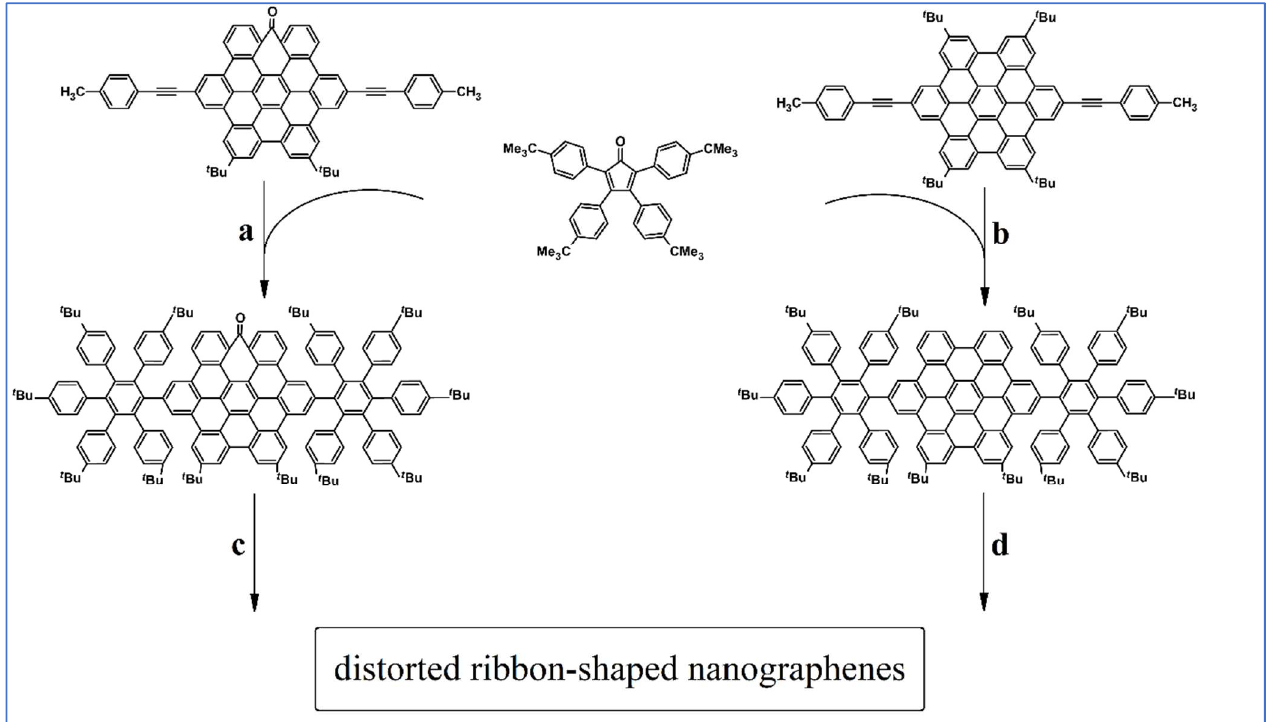
Scheme 188. Synthetic routes leading to distorted ribbon-shaped nanographenes ingaging DA